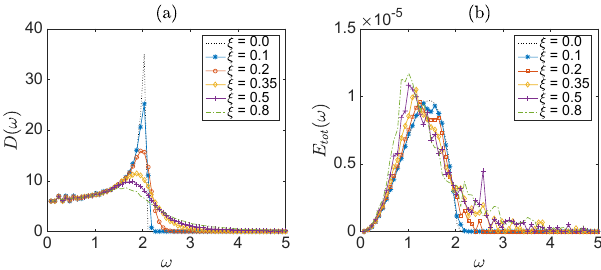
Figure 13. (a) Density of states and (b) energies of the binned fre- quencies for different disorder ξ for all bin sizes in ω